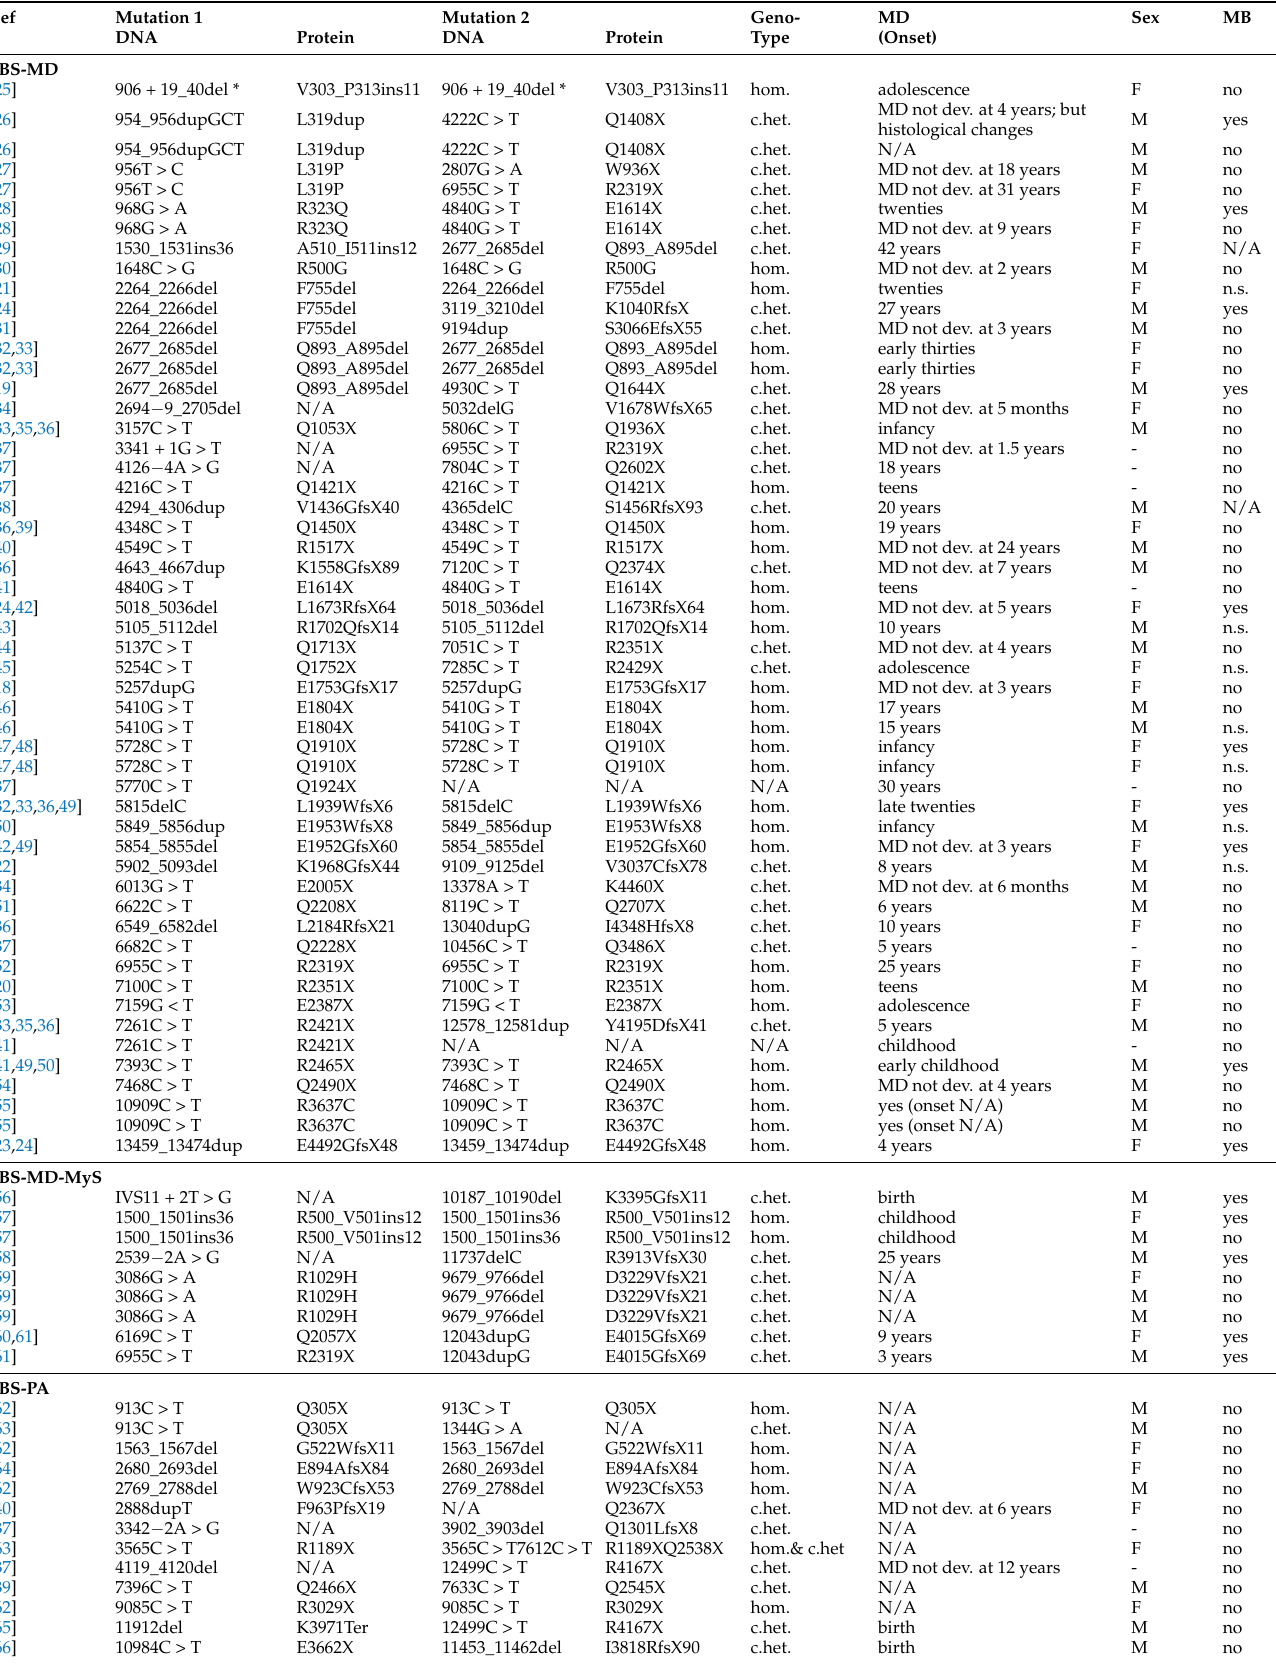
Table 1. Patients with genetically determined PLEC mutations associated with muscle-related disease